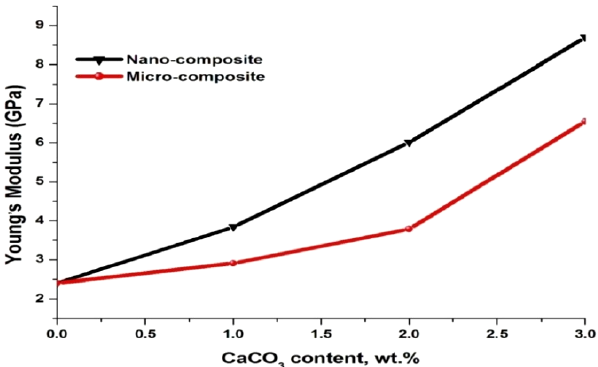
Fig. 5. Effect of filler loading on the Young’s modulus of micro- and nano-Polymer composites.